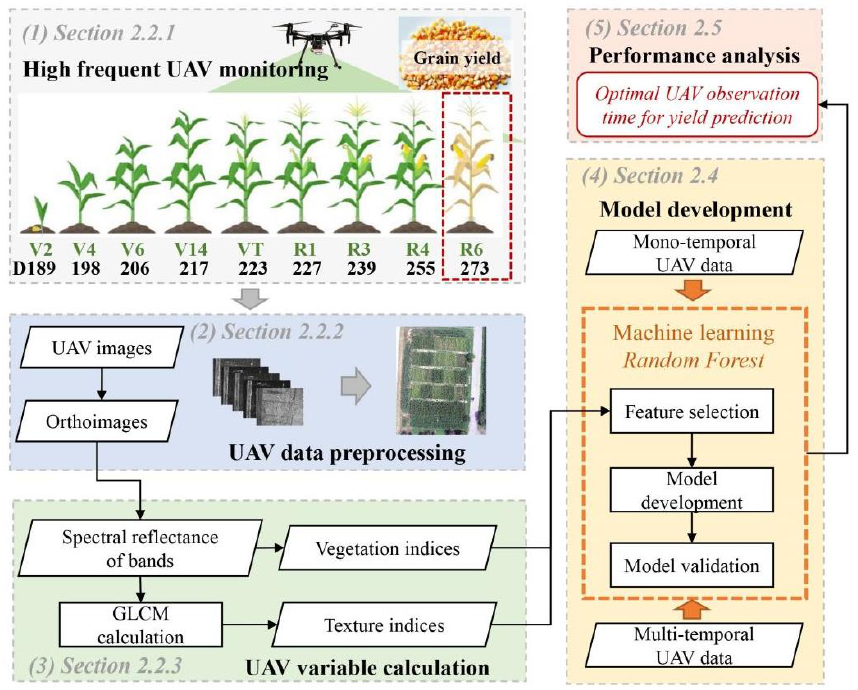
Figure 1. A brief framework for maize yield prediction in this study (GLCM = grey level co-occurrence matrix; V2, V4, V6, V14, VT, R1, R3, R4, and R6 are the second-leaf, fourth-leaf, six-leaf, fourteenth-leaf, tasseling, silking, milking, dough stage, and maturity, respectively; UAV = unmanned aerial vehicle; D = DOY = day of year).